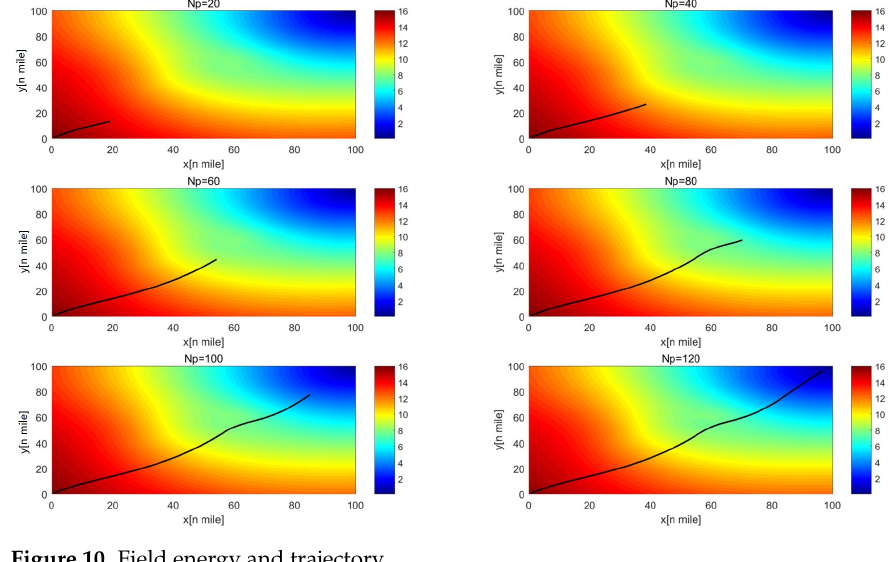
Figure 10. Field energy and trajectory.